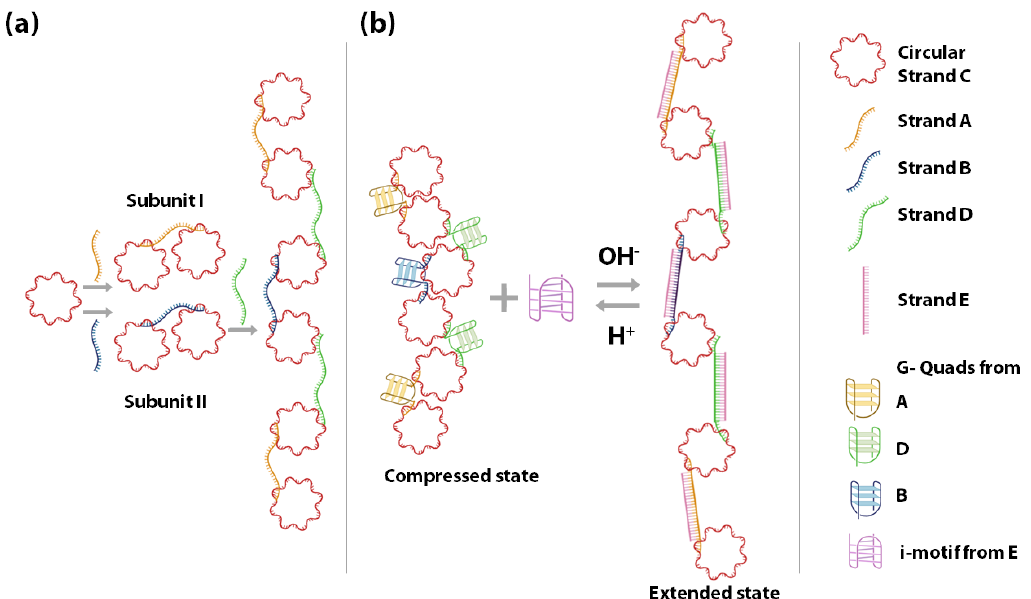
Figure 4. Schematic representation of the proton-fueled DNA nanospring. ( a ) shows the constituent DNA strands and the construction of the nanospring. ( b ) shows the operation of the nanospring with the help of the C-rich strand E, and its compressed and extended state in response to acidic and alkaline pH, respectively [138].